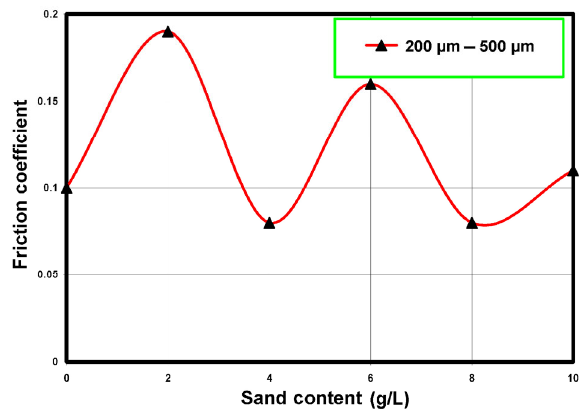
Fig. 8 Effect of sand contamination in lubricant on friction for sand particles of size 200–500 µm.